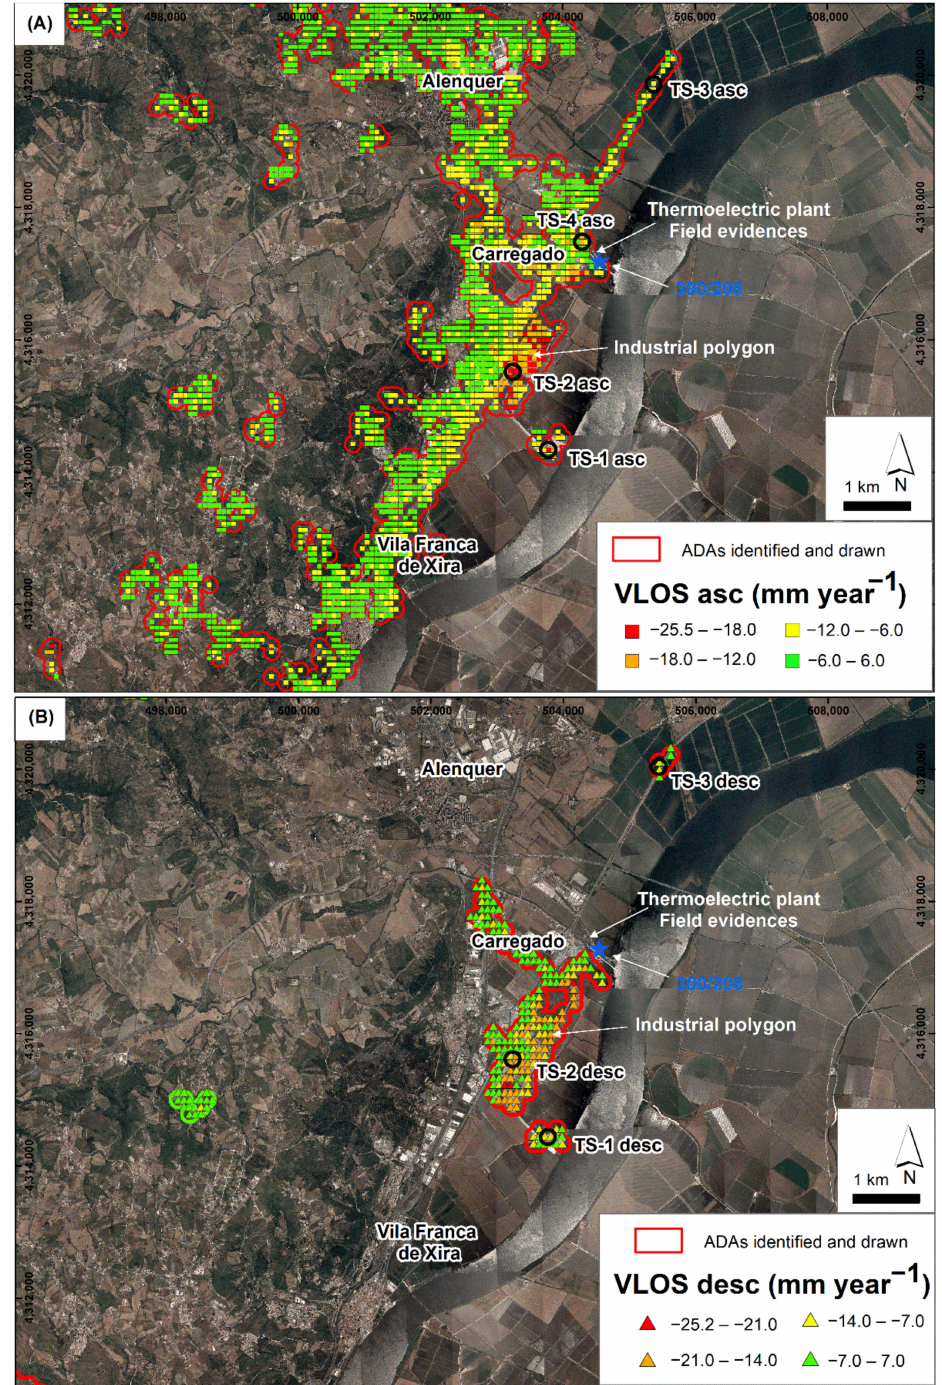
Figure 7. ( A ) ADAs identified and ascending detected PS (only PS into the ADA). ( B ) ADAs identified and descending detected PS (only PS into the ADA). Blue star represents the location of water well 390/208. See location of photos of evidence (Figure 6). Ortophoto 2018, with pixel resolution of 0.25 m, provided by ©Direcç ã o-Geral do Territ ó rio